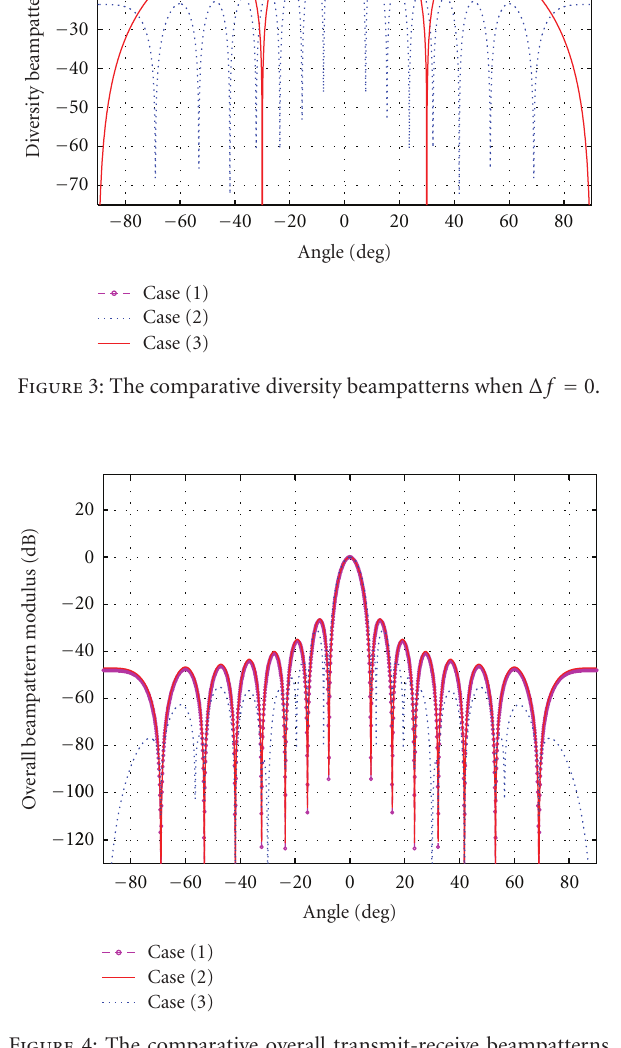
Figure 4: The comparative overall transmit-receive beampatterns when Δ f =